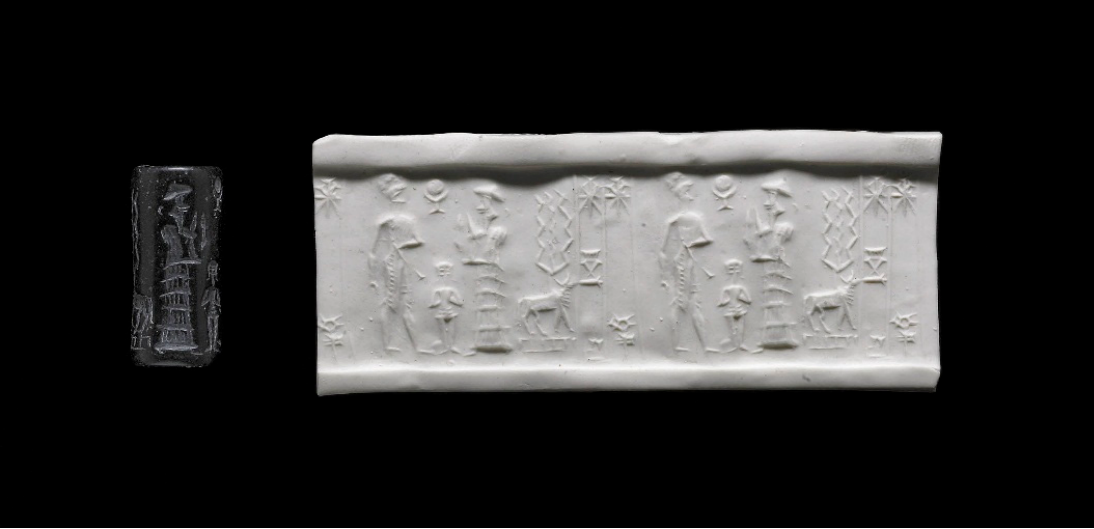
Figure 6. Cylinder seal inscribed Adad, Shala. © The Trustees of the British